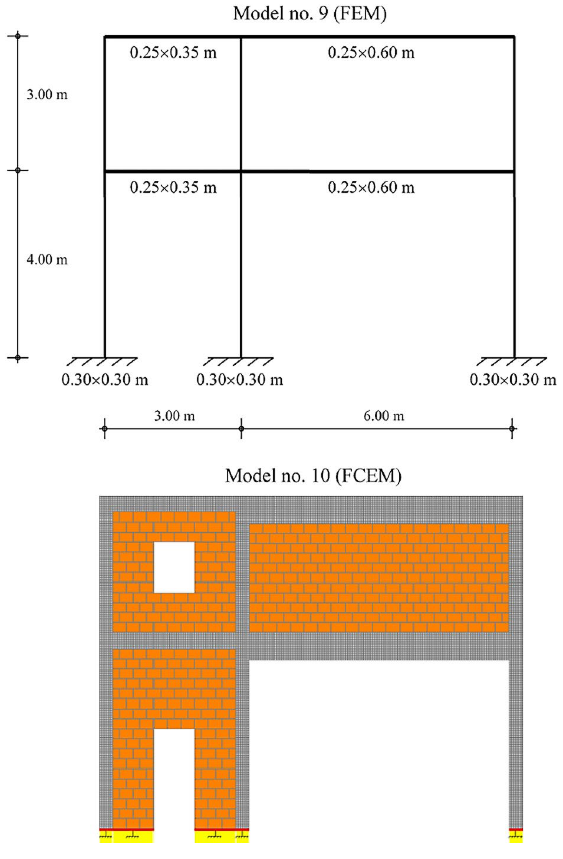
Fig. 7. RC frame with infill walls models adopted for the dynamic analysis carried out with FEM and FCEM